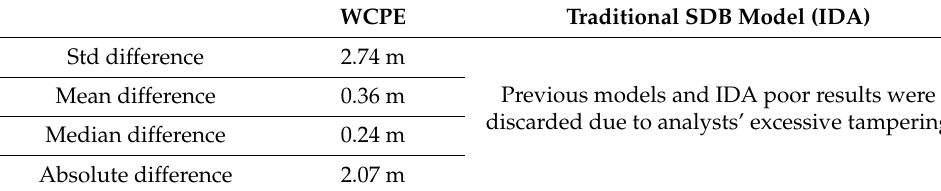
Table 1. Differences between the WCPE and the traditional SDB model against the Tahanea ground truths (Pleiades).